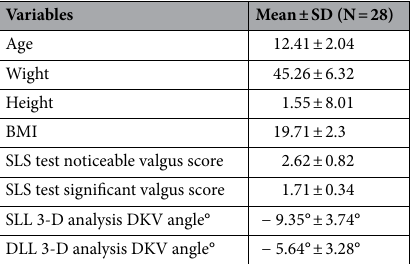
Table 1. Demographic characteristics and determined DKV angle (SLS test: initial selection, 3-D analysis during SLL/DLL: secondary